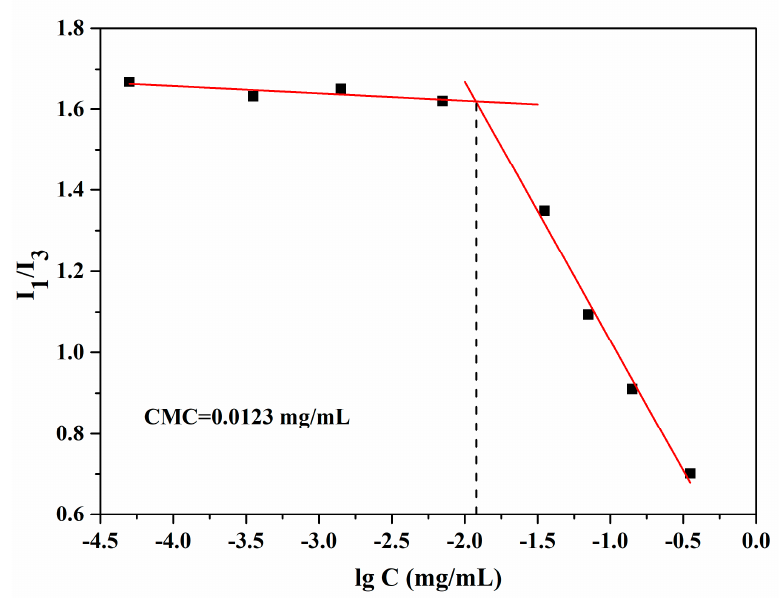
Figure 6. Critical micelle concentration of blank mPEG-PEI-(NBS, OA) upconversion nanomicelles.